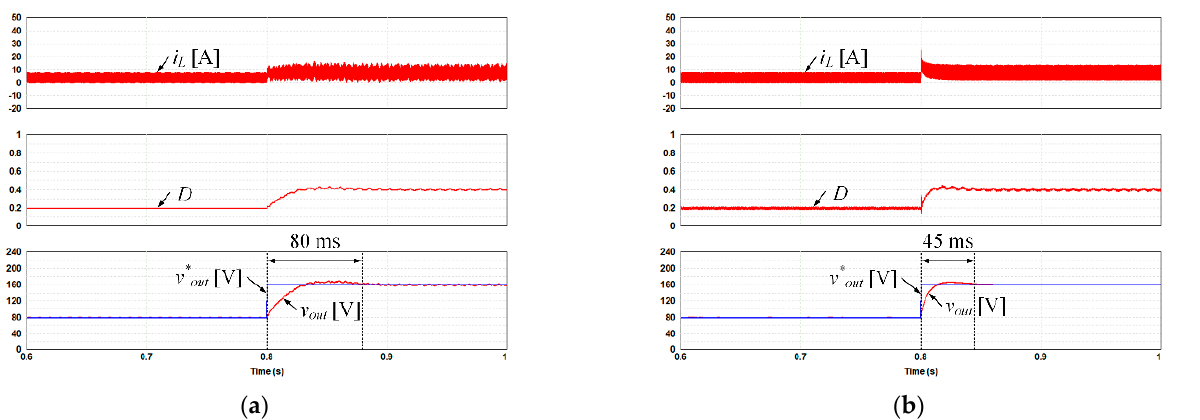
Figure 10. Simulation results of output voltage control of integrated OBC using ( a ) PI control and ( b ) the proposed MPC method.